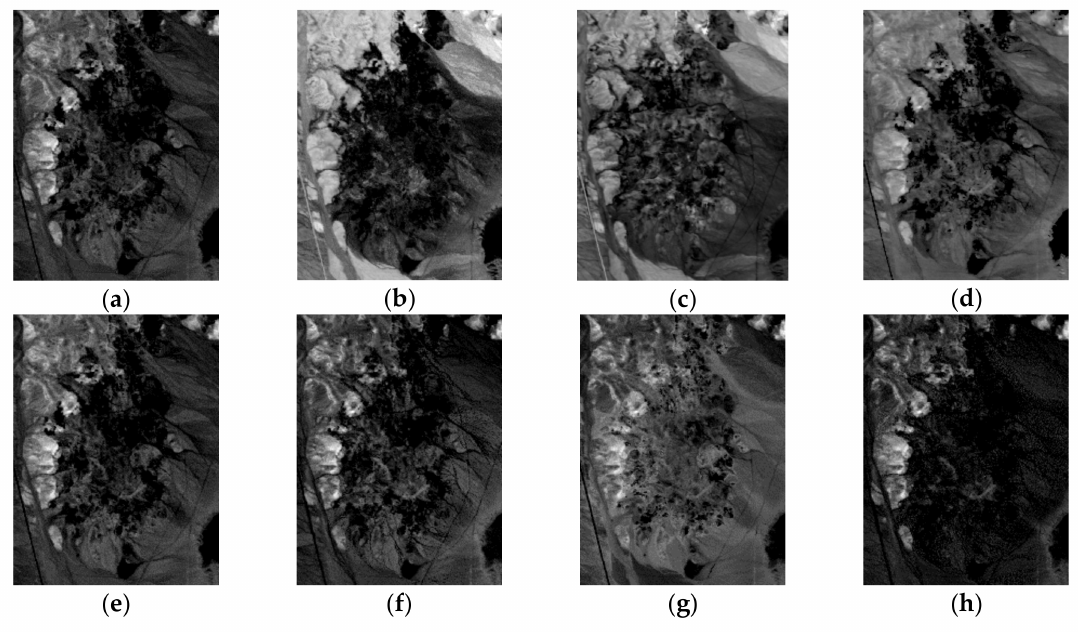
Figure 12. Sphene: ( a ) VCA, ( b ) N-FINDR, ( c )SGA, ( d ) C-NMF, ( e ) MVC-NMF, ( f ) ICE, ( g ) SPICE, ( h )